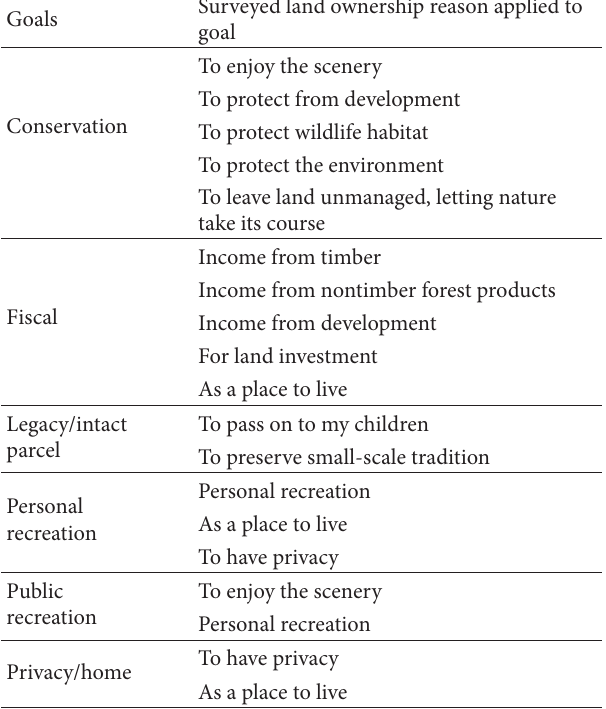
Table 2: The FLAME land ownership goals. A listing of the question responses that were assigned to the initial 6 goals in order to calculate initial goal scores. Intact parcel and home goals were added based on stakeholder recommendations; however, they were populated using similar data distributions as legacy and privacy. The questions were based on the national woodland owner survey regarding reasons for owning land on a 5-point Likert scale: “How important to you are each of the following reasons for owning this parcel?”.